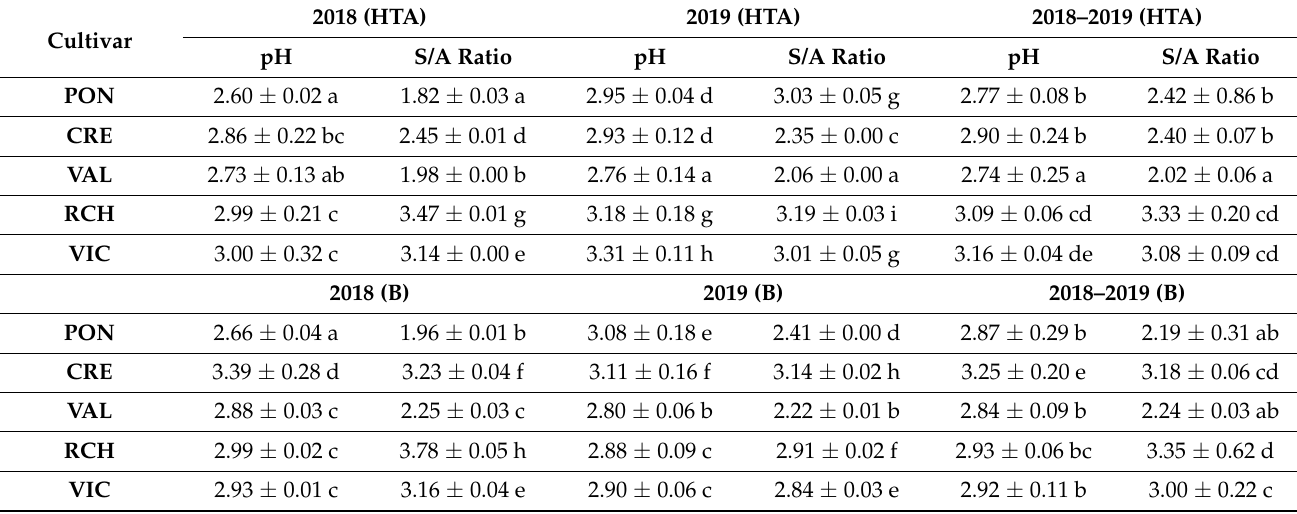
Table 10. Effect of cultivar on pH level and the S/A ratio in rhubarb juice. Cultivar